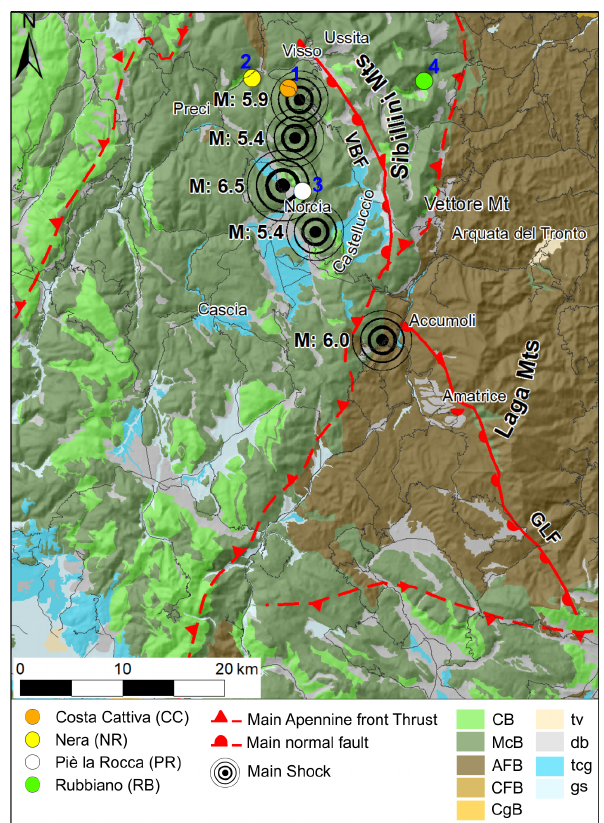
Figure 1. Epicenters of the 2016–2017 central Italy seismic se- quence (CISS) and location of the studied landslides on a simpli- fied geological map (modified after Forte et al., 2019). Keys: car- bonate bedrock (CB), marly carbonate bedrock (MCB), arenaceous flysch bedrock (AFB), clayey flysch bedrock (CFB), conglomer- ate bedrock (CgB), travertine (tv), debris (db), terraced conglom- erates (tcg), gravels and sands (gs), Gorzano–Laga fault (GLF), and Vettore–Bove fault